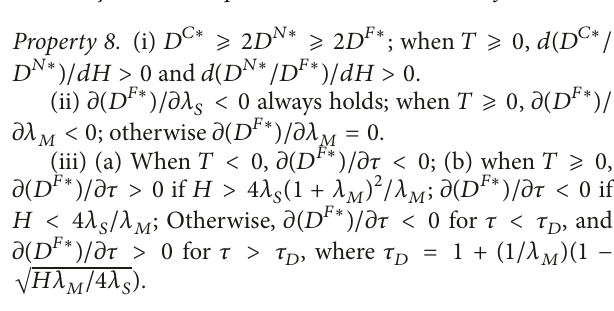
in a quality-sensitive